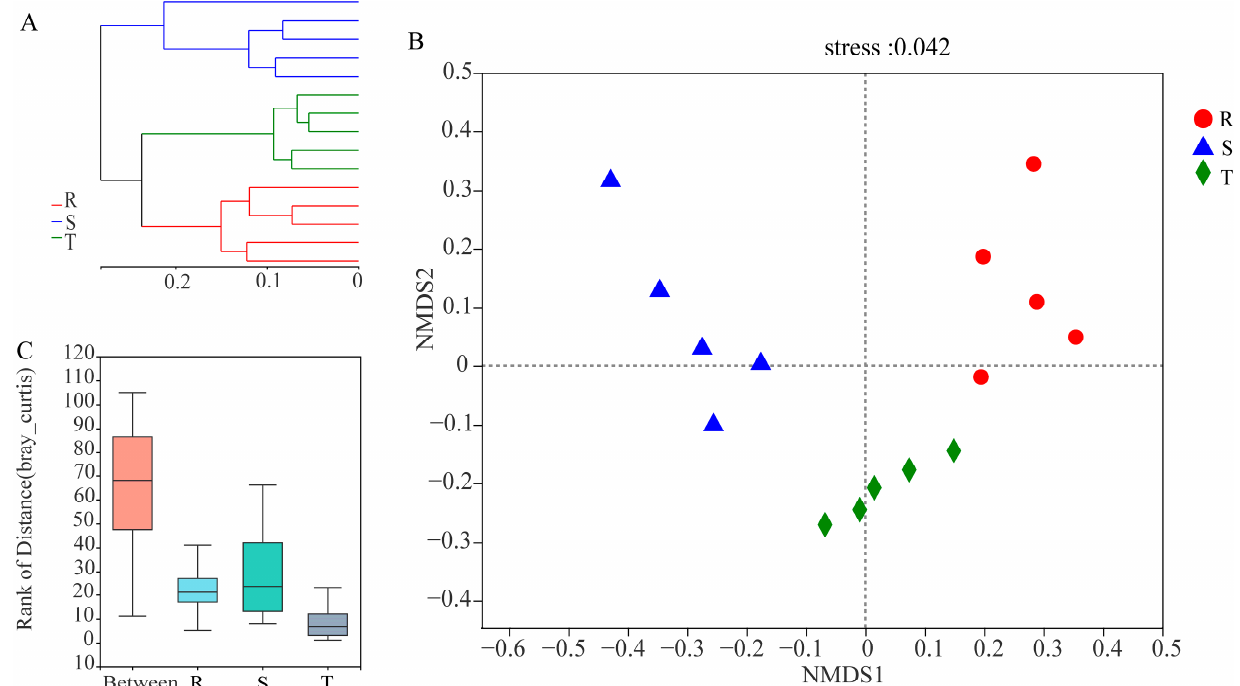
Figure 2. Beta diversity analysis of three soil nematode communities . ( A ), Hierarchical clustering analysis. ( B ), NMDS. ( C ), ANOSIM. S: susceptible cultivar. T: tolerant cultivar. R: resistant cultivar.